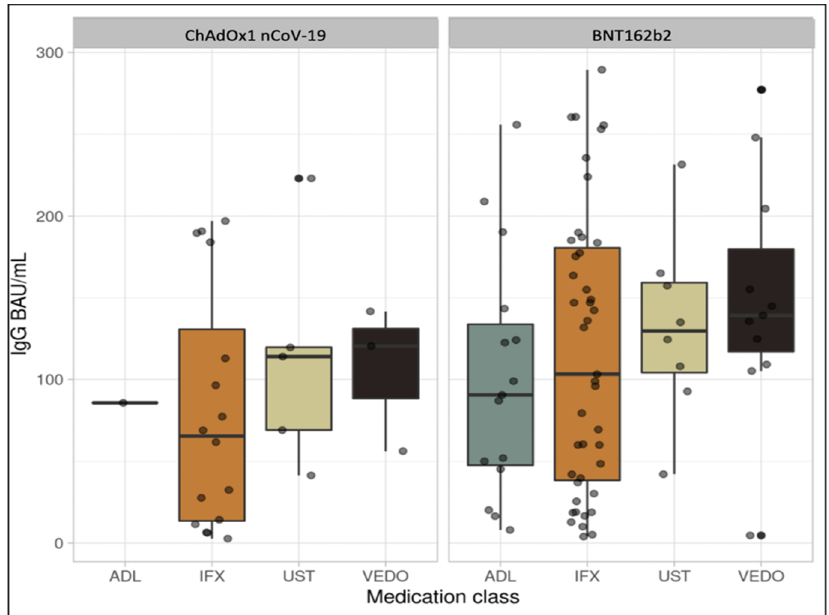
Table 2. Serological response in participants vaccinated with the BNT162b2 vaccine and receiving biologic therapies.